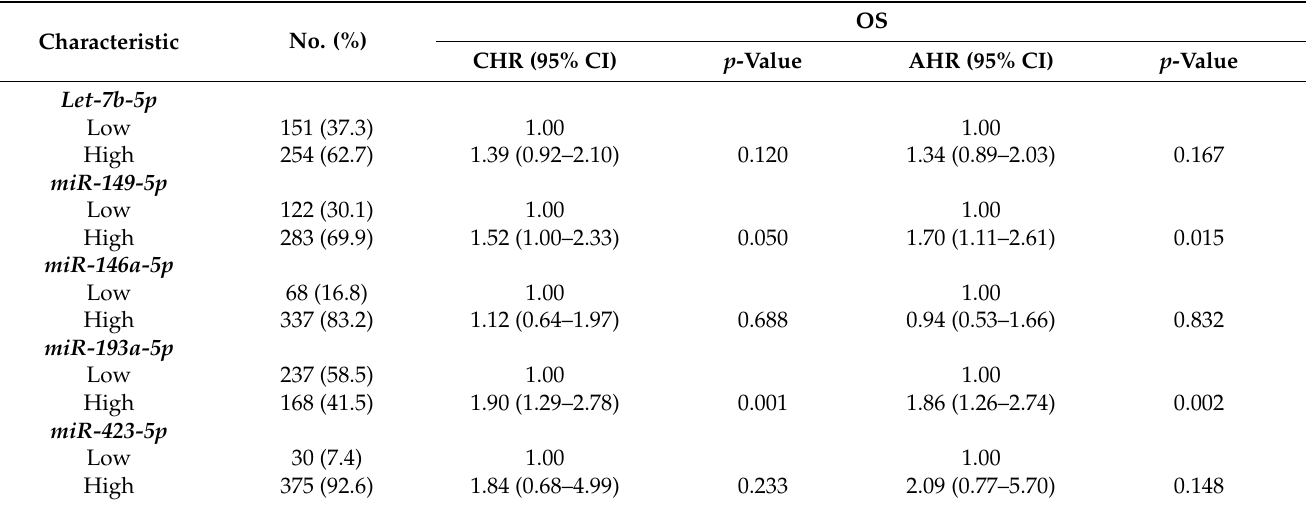
Student’s t tests. Table 1. Univariate and multivariate Cox’s regression analysis of gene expression for overall survival of 405 patients with bladder